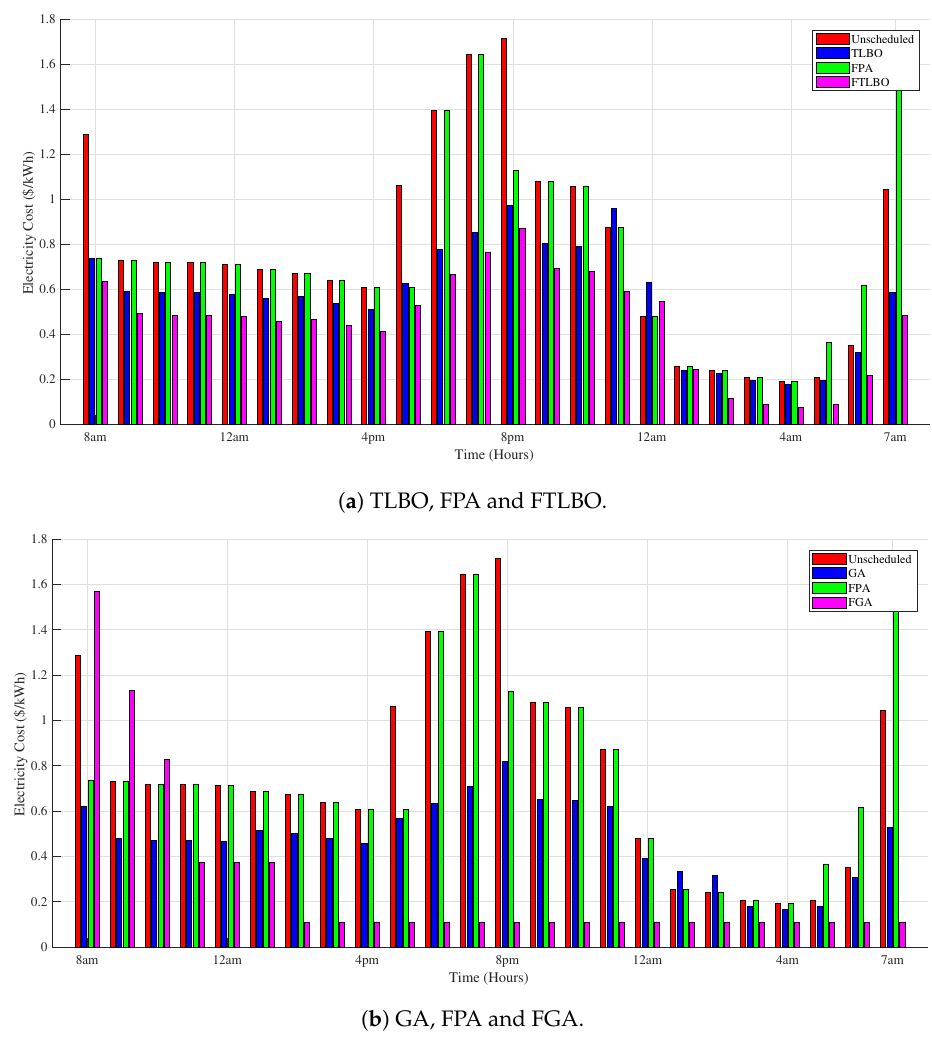
Figure 8. Hourly electricity cost of appliances. ( a ) TLBO, FPA and FTLBO; ( b ) GA, FPA and